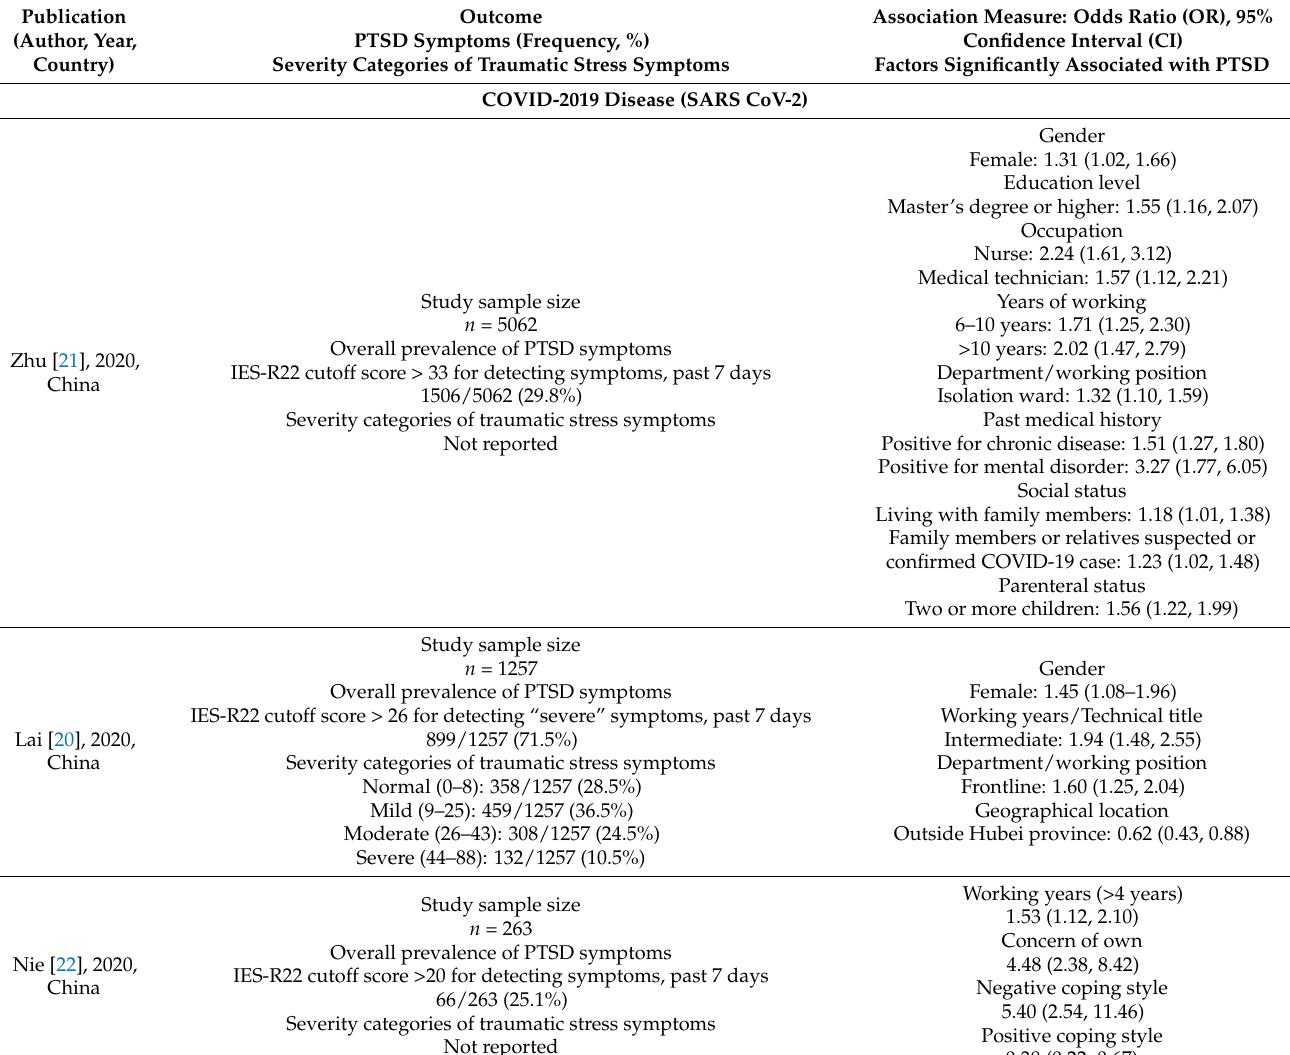
Table 3. Summary of studies that reported prevalence (frequency, %), severity, and factors significantly associated with post-traumatic stress disorder (PTSD) symptoms following multivariable logistic regression for COVID-19 disease (SARS CoV-2) and SARS-2003 (SARS